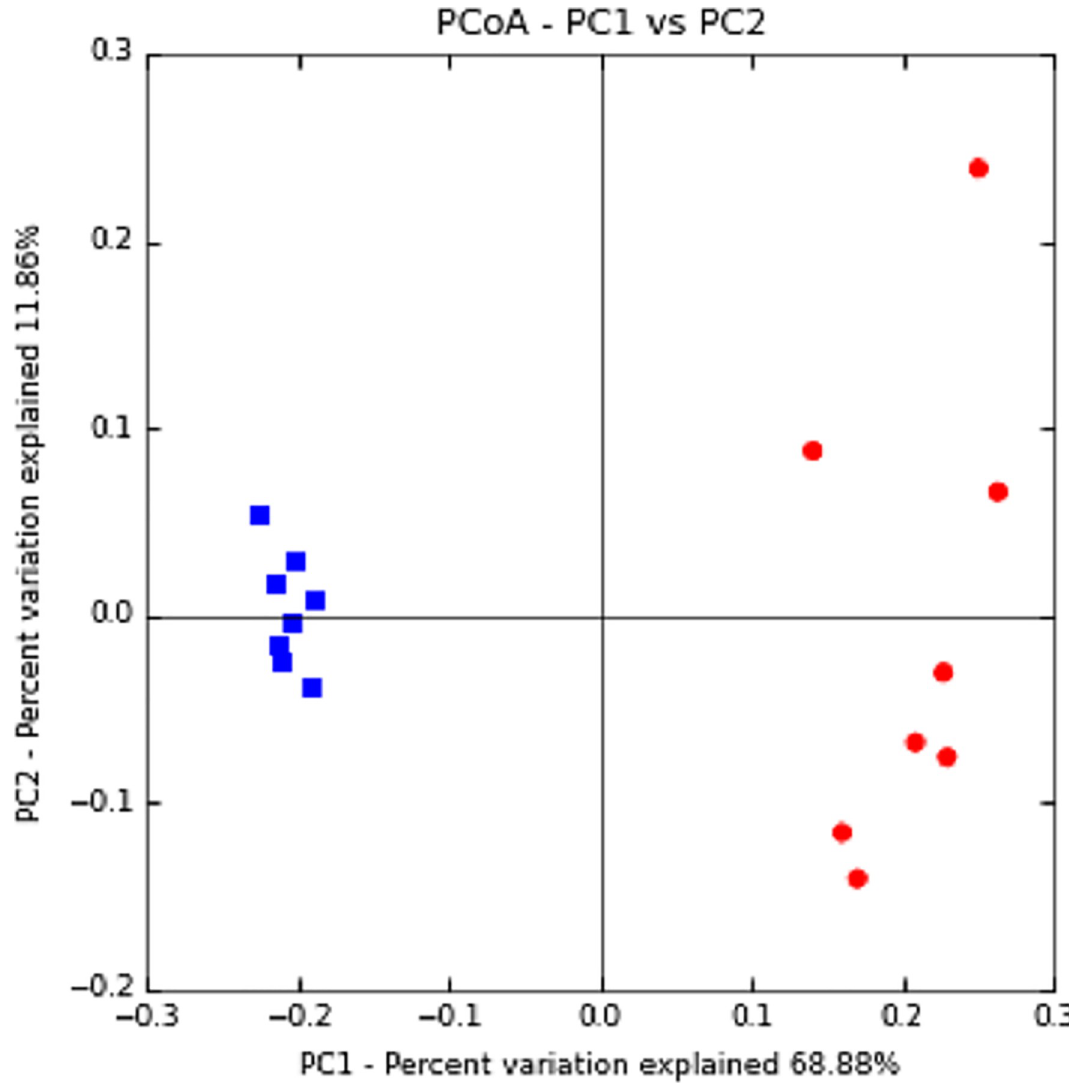
Fig 2. A principal-coordinate analysis plot of the oral microbiota based on the results of the unweighted UniFrac metric. Scatter plot of principal coordinate 1 (PC1) versus principal coordinate 2 (PC2) is shown. The first axis (PC1) explains the maximum amount of variation present, followed by the second axis. Percentages shown are percentages of variation explained by the components. Each point represents a single sample, and the distance between points represents the compositional difference of the samples from each other. ■ : marmoset, � :